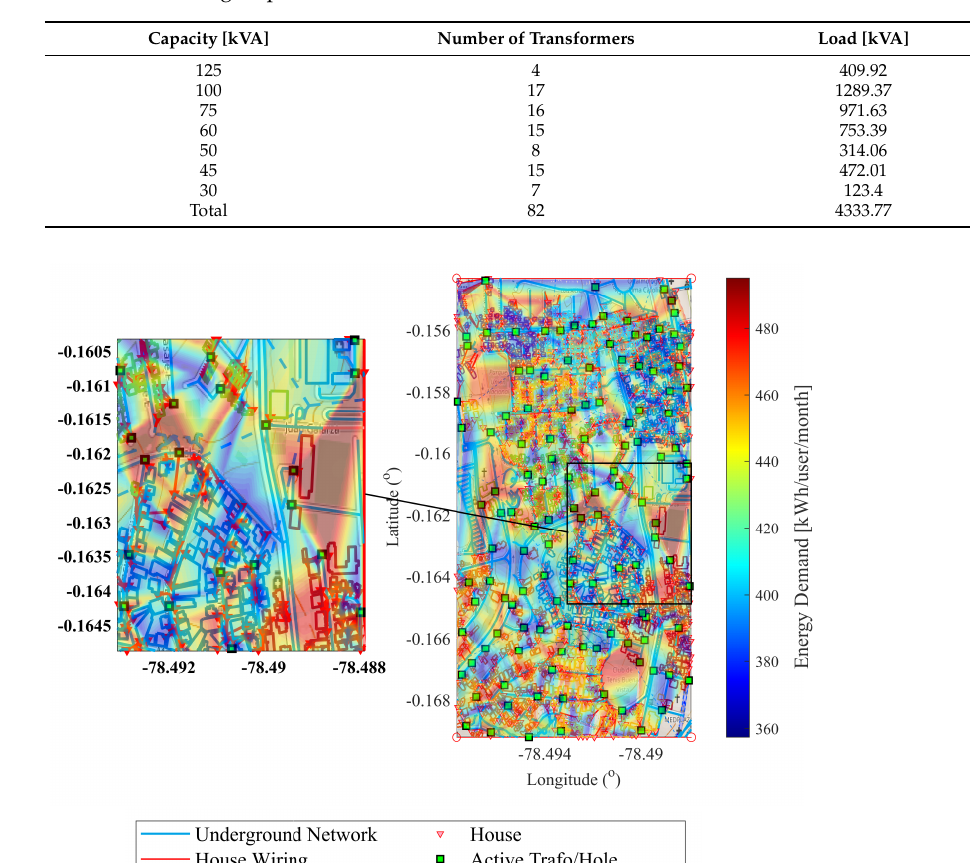
Table 4. Load for group of transformers.